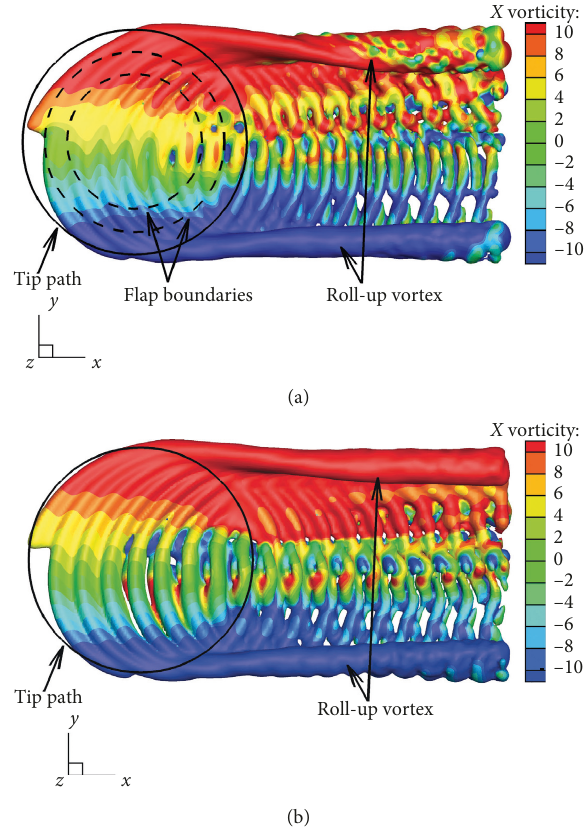
Figure 6: Vorticity isosurfaces diagram of the wake flow field for the ECR and conventional rotor. (a) ECR with 6 ∘ pre-index angle; (b) conventional rotor.